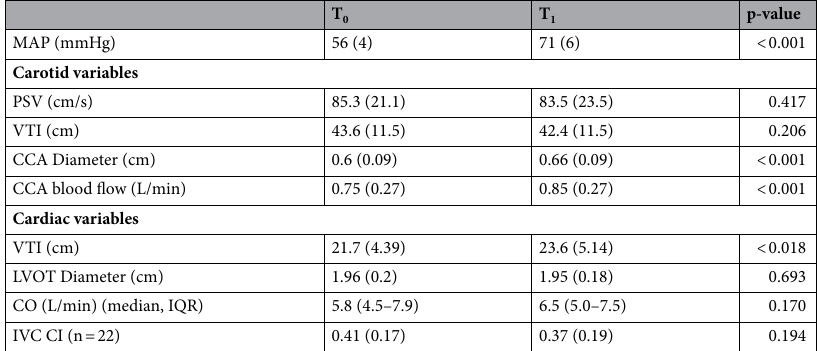
Table 2. Carotid variables by POCUS and cardiac variables by TTE before (T 0 ) and after (T 1 ) initiation of norepinephrine. POCUS, point-of-care ultrasound; MAP, mean arterial pressure; TTE, transthoracic echocardiography; PSV, peak systolic velocity; VTI, velocity time integral; CCA, common carotid artery; LVOT, left ventricular outflow tract; CO, cardiac output; IVC CI, inferior vena cava collapsibility index. Data are presented as mean (standard deviation) and median (IQR, interquartile